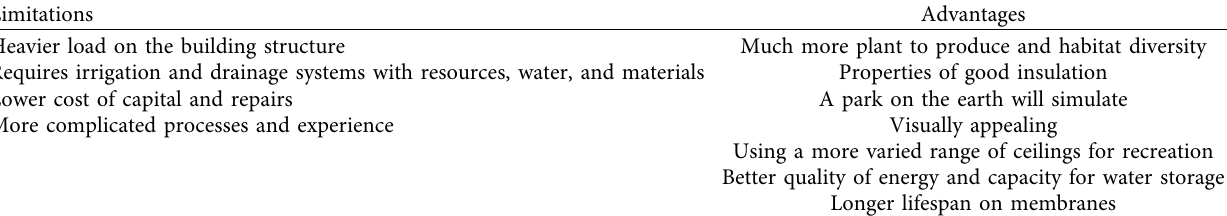
Table 5: Advantages and limitations of intensive systems.